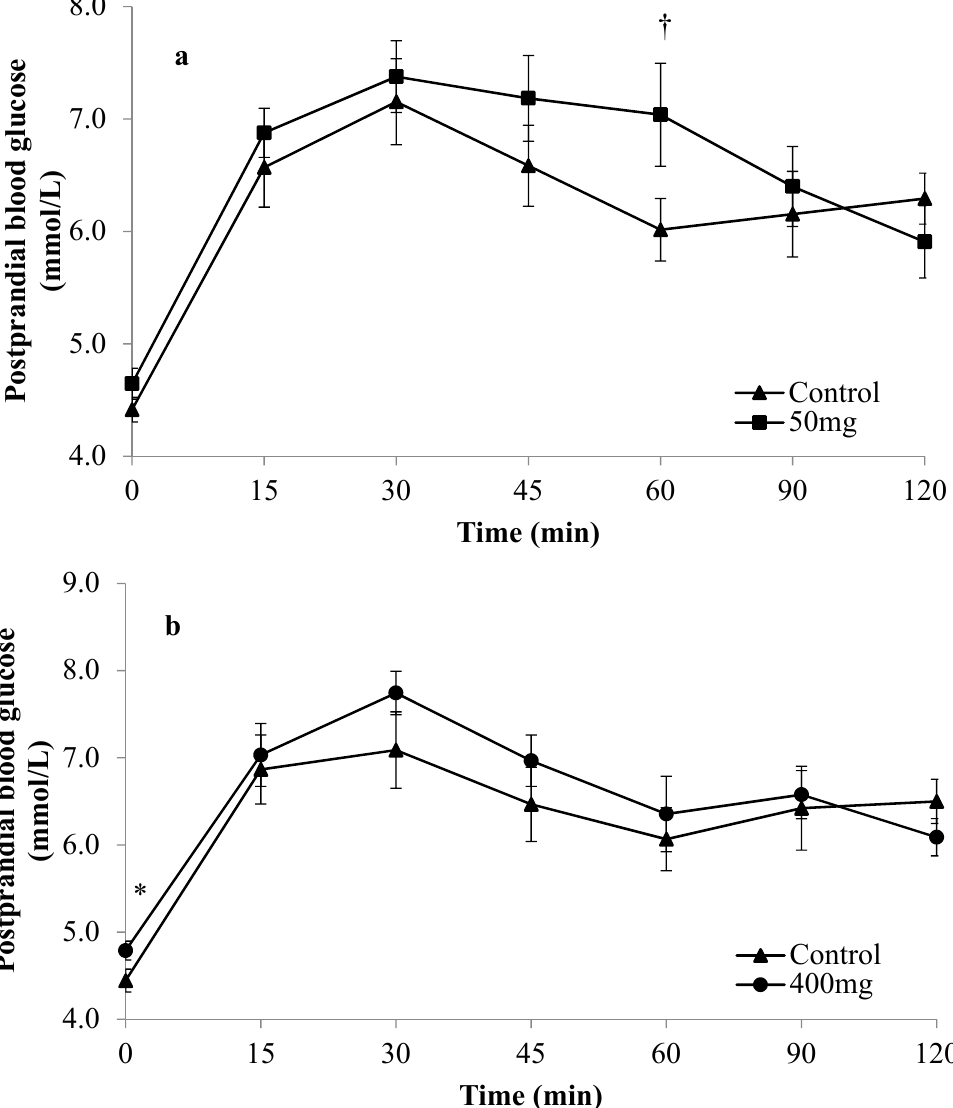
Figure 2. Mean postprandial glucose ( ± SEM) of participants with a complex glucose curve shape during control and treatment visits with ( a ) 50 and ( b ) 400 mg of Enzogenol ® . † p < 0.05 for 50 mg Enzogenol ® compared to control, * p < 0.05 for 400 mg Enzogenol ® compared to control.